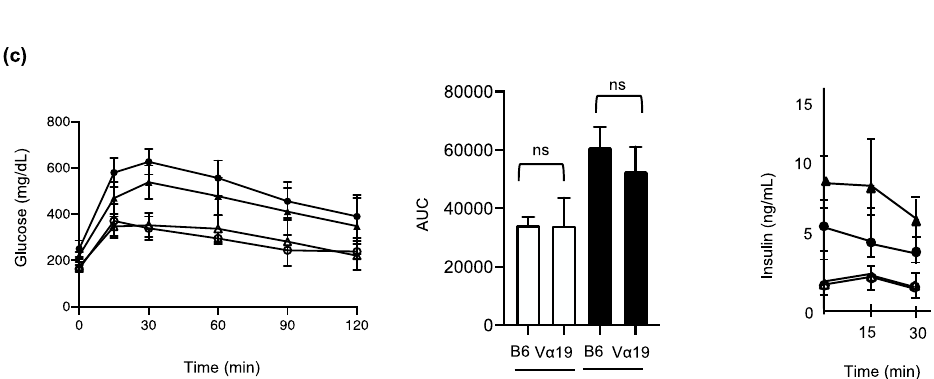
Figure 5. Hepatic gluconeogenesis-related genes decreased, but systemic glucose metabolism and insulin sensitivity were not altered, in Va19 mice. (a) mRNA levels for hepatic gluconeogenesis- related genes in Va19 mice (Va19) and C57BL/6 mice (B6) at 27 weeks of age fed normal chow (NC) and a high-fat diet (HFD). Data on each mRNA were normalized according to the 36B4 mRNA level. (b)(c) Intra-peritoneal insulin tolerance test (ipITT) and (b) intra-peritoneal glucose tolerance test (ipGTT) (c). ipITT and ipGTT were performed after fasting for 4 h. Open circles, B6 mice fed NC; open triangles, Va19 mice fed NC; closed circles, C57BL/6 mice fed HFD; closed triangles, Va19 mice fed HFD. * p < 0.05, ns, not statistically significant.